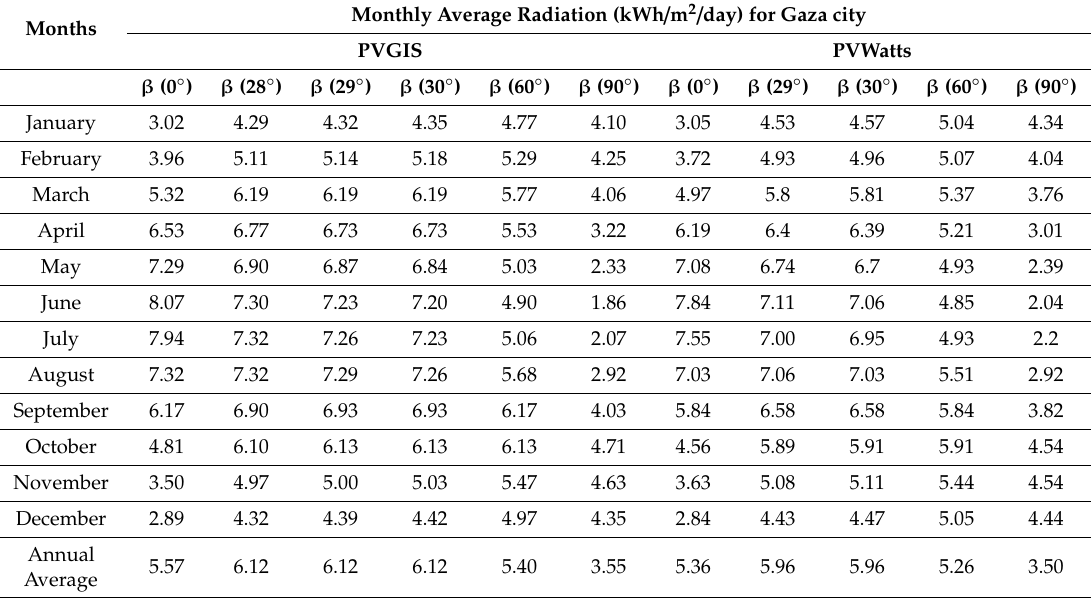
Table 16. The monthly average global radiation in Gaza city for di ff erent tilt angles ( β ).